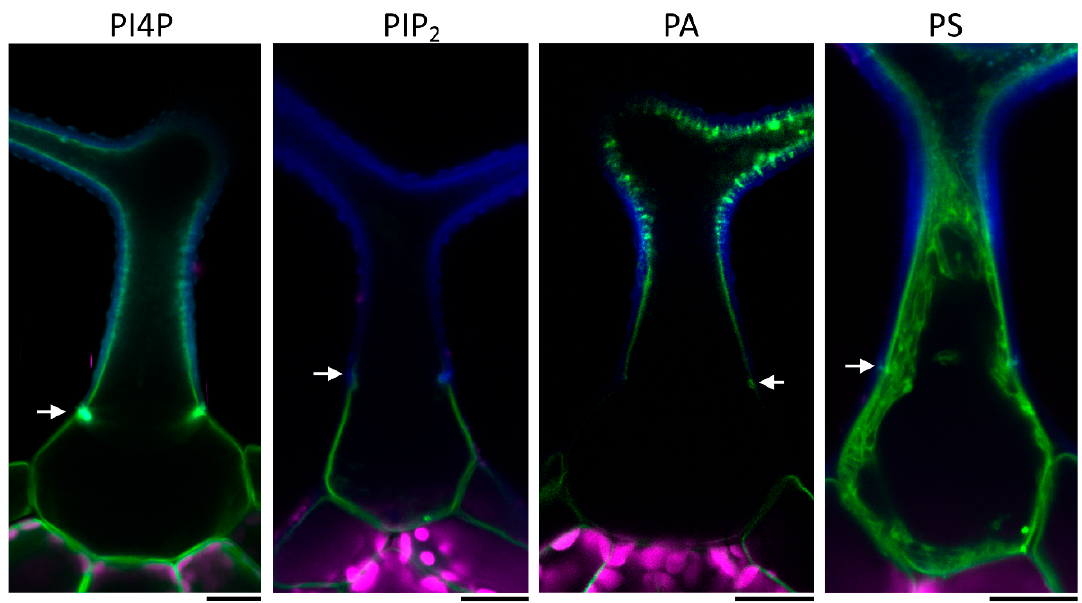
Figure 1. Representative images of different phospholipid markers in wild type mature trichome. PI4P—phosphatidylinositol-4-phosphate; PIP 2 —phosphatidylinositol 4,5-bisphosphate; PA—phosphatidic acid; PS—phosphatidylserine. Blue—cell wall autofluorescence; magenta—chlorophyll autofluorescence; green—mCitrine or YFP (yellow fluorescent protein). White arrows point at the Ortmannian ring. Scale bars = 20 µm.